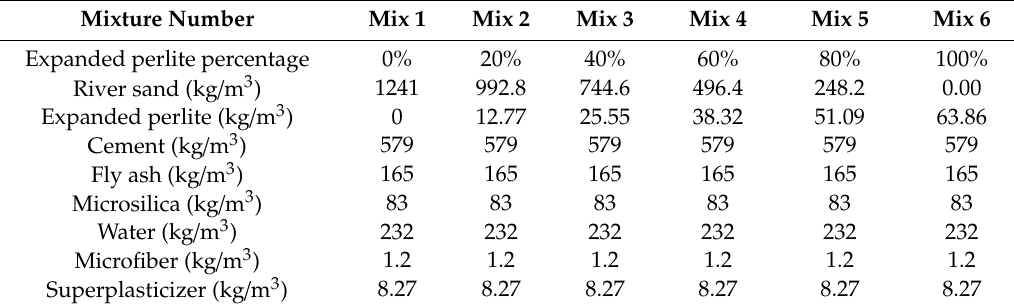
Table 1. Proportions of materials used in the six mixtures.